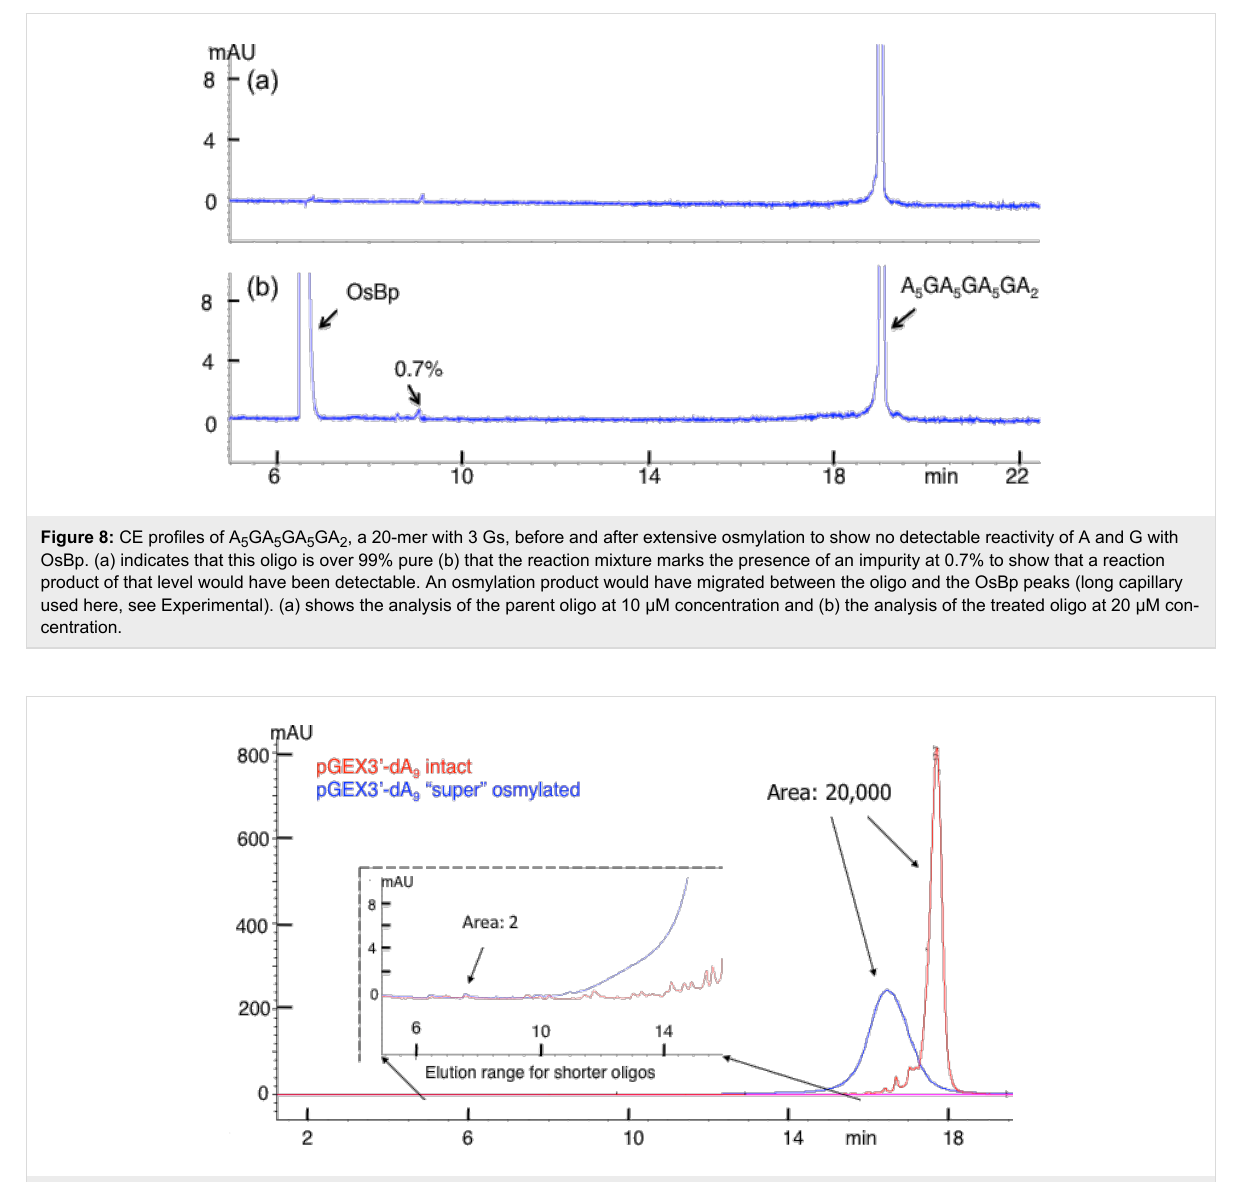
Figure 9: Overlapping HPLC profiles of intact oligo and the corresponding product resulting by “super” osmylation analyzed using a high-load injec- tion. Oligo pGEX3’-dA 9 , a 32-mer (Table 1), is >95% pure, and does not exhibit impurities, i.e., shorter oligos, in the range of 10 to 20-mers (see insert). The osmylated product elutes as a broad peak, but does not exhibit any degradation products, as seen in the insert. The area of a peak with 2 (HPLC units) is marked to visualize the detectability level for a tentative backbone degradation. Note the 32-mer would have eluted at a later